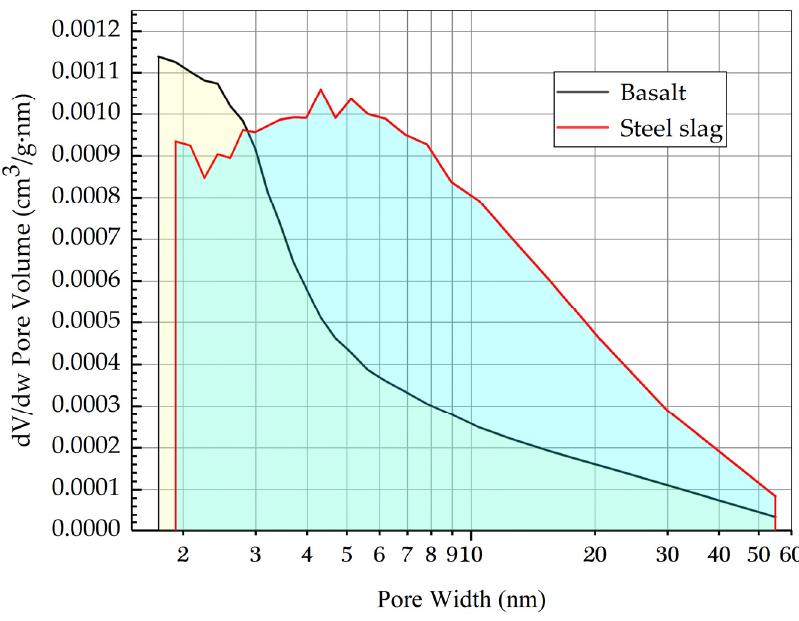
Figure 7 SEM morphology of ( a ) steel slag, ( b ) basalt.